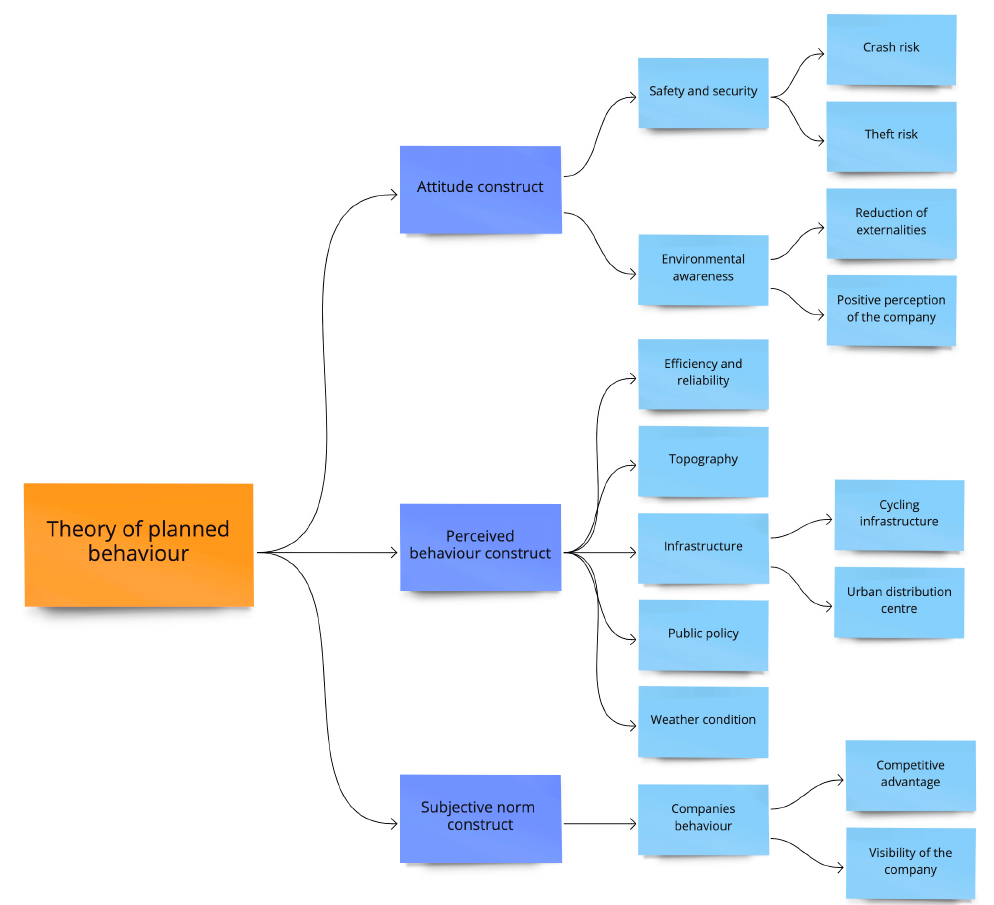
Figure 2. Constructs and respective variables (beliefs) regarding last-mile bicycle delivery.